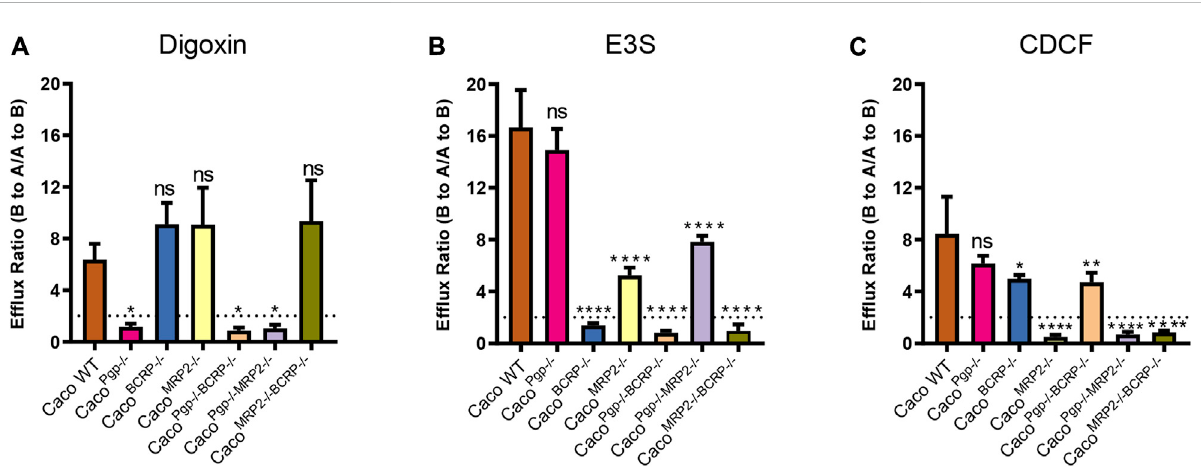
FIGURE 5 Ef fl uxratiosforprobesubstratesdigoxin (A) ,estrone3-sulfate (B) ,andCDCF (C) inWTandKOcelllines.Eachbarrepresentsthemean±SD.;n= 3. The dotted line indicates the ER = 2. ns: not signi fi cant; * p < 0.05; ** p < 0.01; *** p < 0.001; **** p < 0.0001.